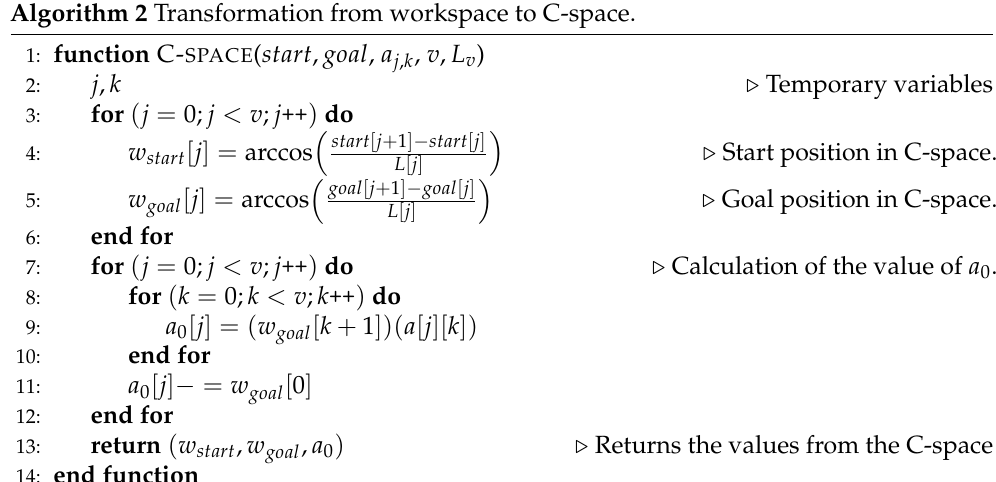
Algorithm 2 Transformation from workspace to